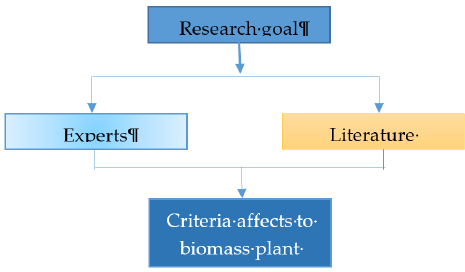
Figure 2. Processes of selection criteria.